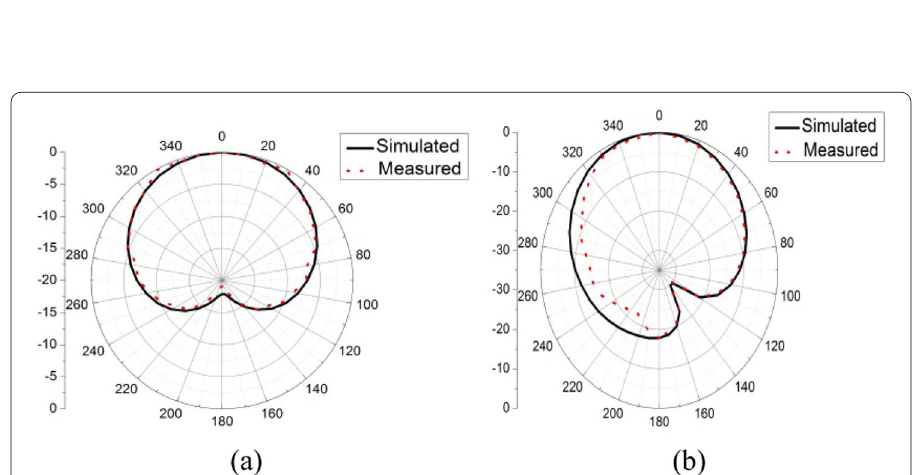
Fig. 16 Simulated and measured E plane ( a ) and H plane ( b ) radiation pattern of proposed